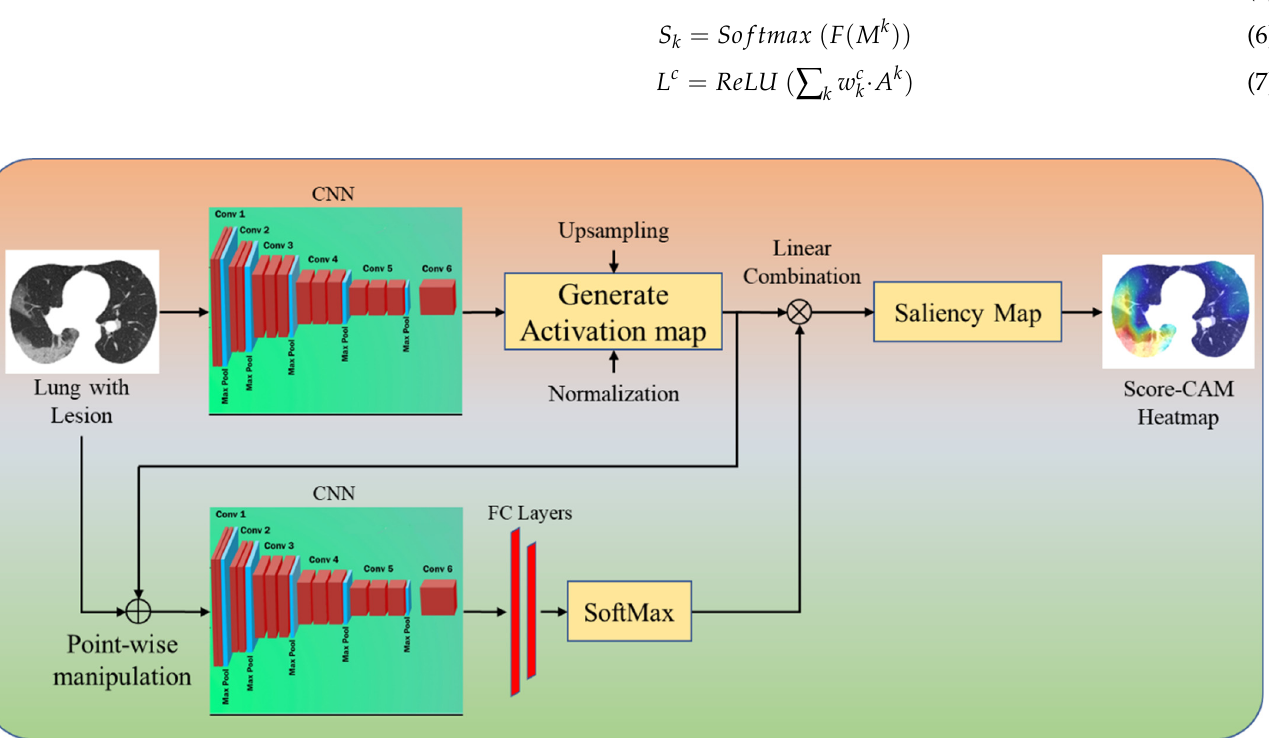
Figure 7. Score-CAM++. Figure 7.